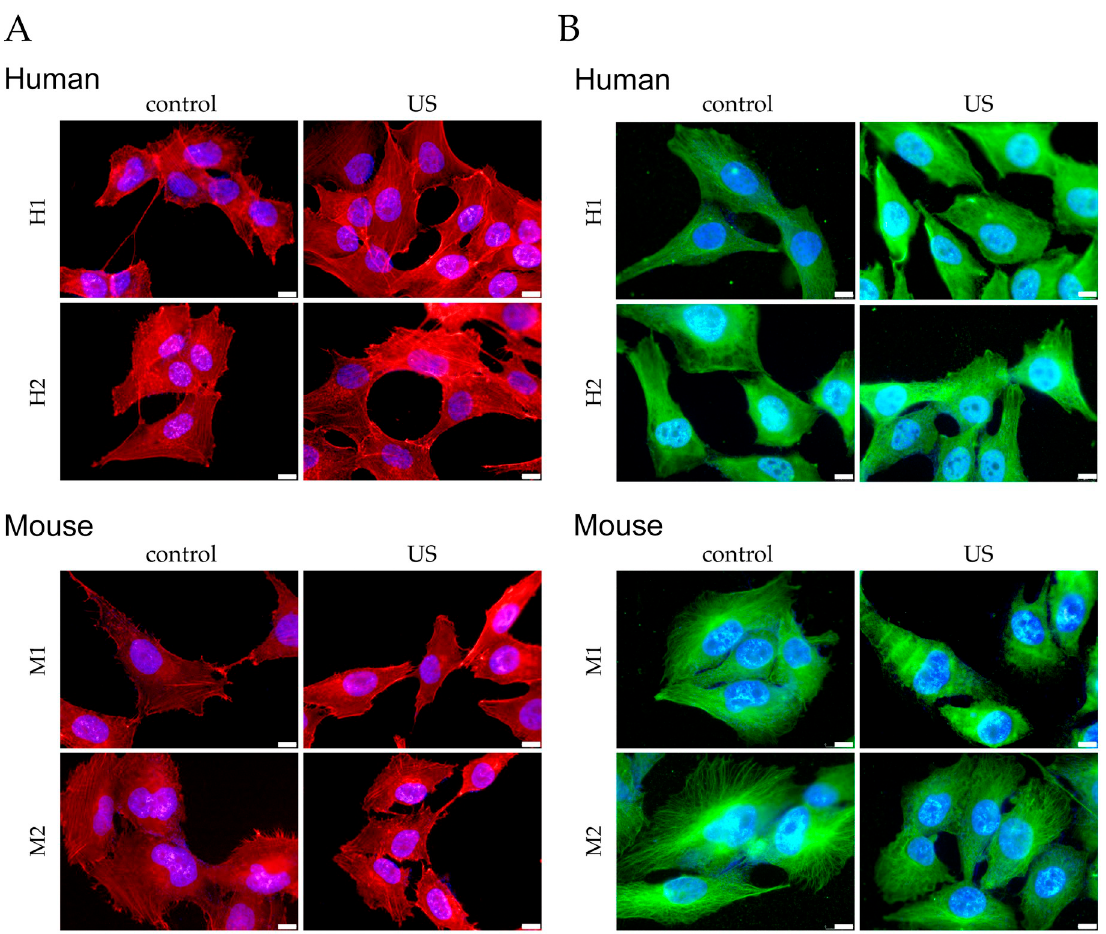
Fig 3. Application of LIPUS does not affect the cytoskeletal organization of s-MPs. Control cells and cells stimulated with LIPUS (US) for 3 days were stained with (A) phalloidin-TRITC to visualize F-actin (red) and (B) β -tubulin to visualize microtubules (green). Nuclei were counter-stained with DAPI (blue). Shown are two independent samples of mouse (M1 and M2) and human (H1 and H2) s-MPs. Images are shown at a magnification of 63 × , scale bar 10 μ m.